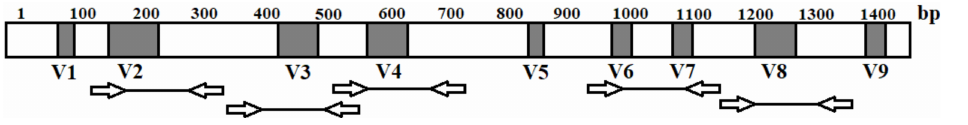
Figure 8. Five regions of the 16S rRNA amplified using V2, V3, V4, V6–7, and V8 domain-specific primers from the 16S Metagenomic kit (Thermofisher Scientific) used for multi-variable region-based 16S rRNA gene high-throughput sequencing